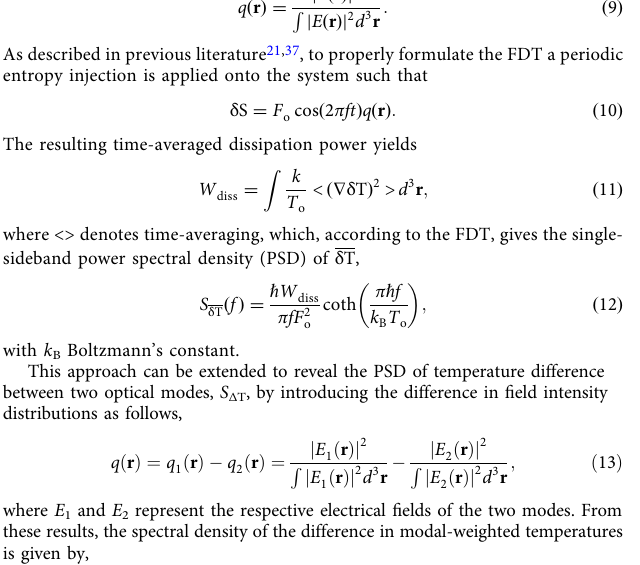
Fig. 7 TRN measurement and resonator geometry. a TRN measurement setup. MZI Mach – Zehnder interferometer, OSC oscilloscope, PD photodiode, PM phase modulator. b Cross-sectional view of the microresonator. Multiple transverse modes are supported in the suspended wedge-shaped whispering gallery. The surrounding silica, silicon, and air serve as a heat reservoirs. The ambient temperature is denoted by T o